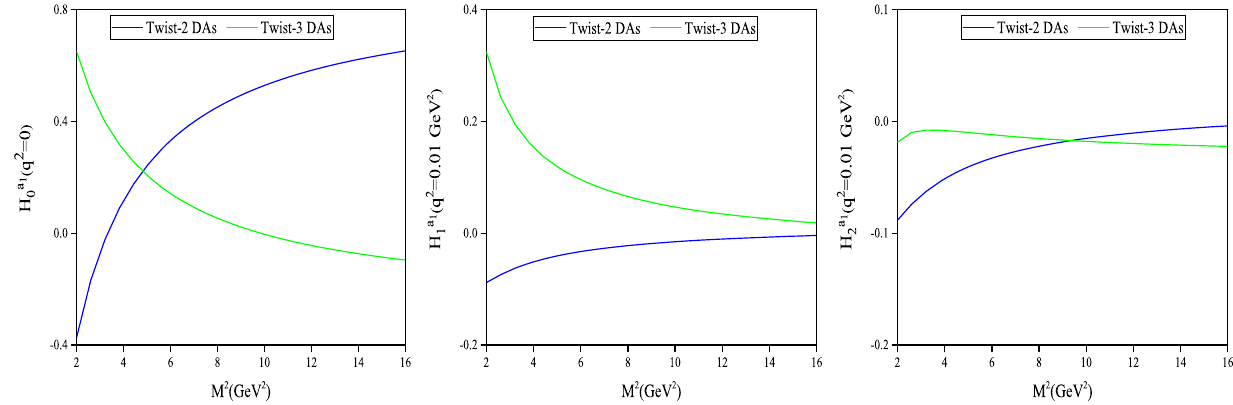
Fig. 1 D 0 → a − helicity form factors as functions of M 2 . For H a 1 1 The threshold parameter is taken s 0 = ( 7 ± 0 . 2 ) GeV 2 for every plot